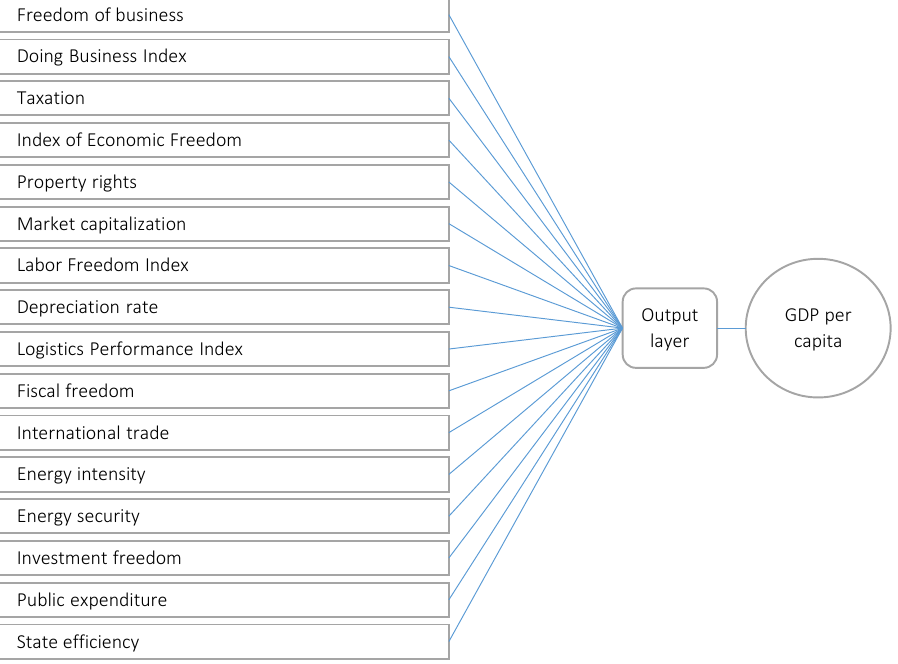
Figure 2. The structure of the model with a neural component with one source to determine the relationship between performance indicators of reforms and sustainable development programs and the volume of GDP per capita in